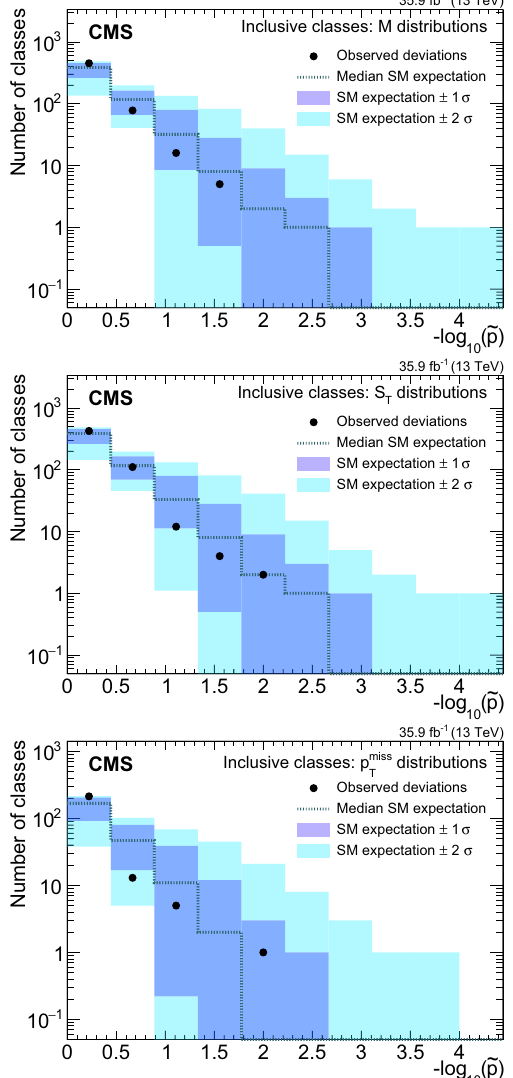
Fig. 11 Distribution of ˜ p values for the RoI scan in exclusive classes for the M (upper), S T (middle), and p miss